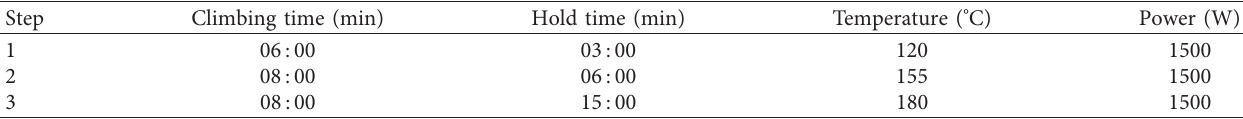
Table 1: The condition of microwave digestion.